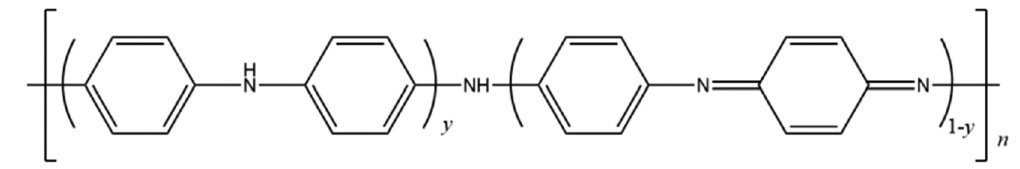
Figure 1: Oxidation - reduction ( REDOX ) unit of PANI.